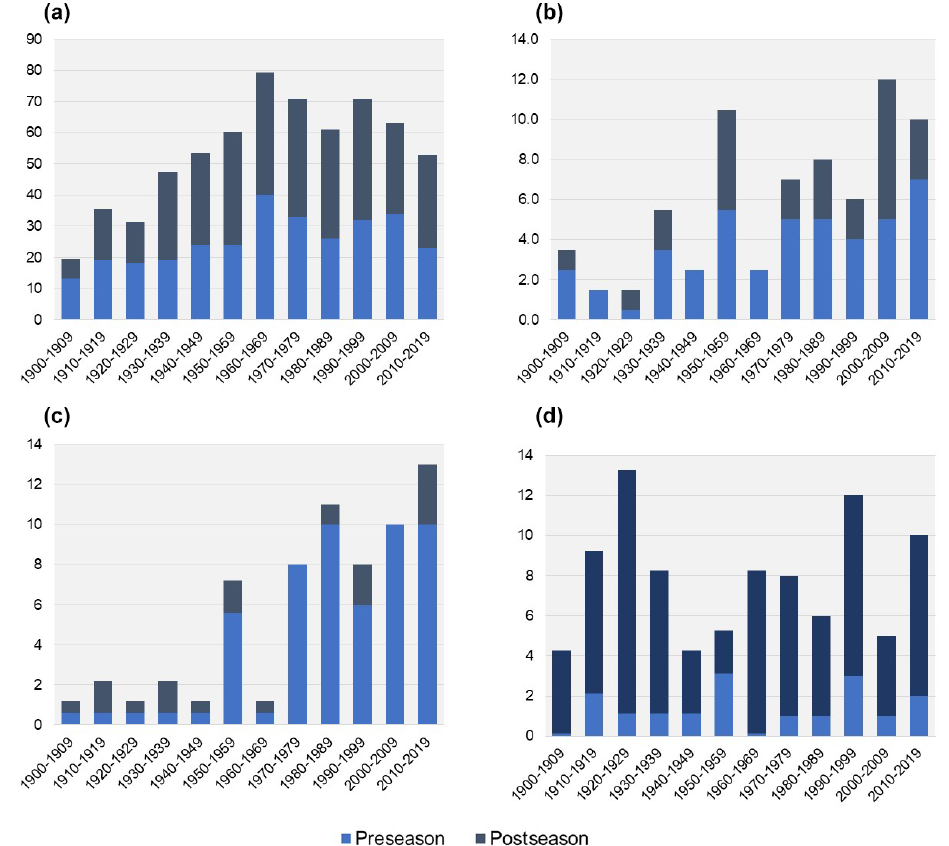
Figure 2. Adjusted decadal count of all observed and estimated off-season TCs for the WP (a) , NA (b) , EP (c) and SP (d) ocean basins for the 1900–2019